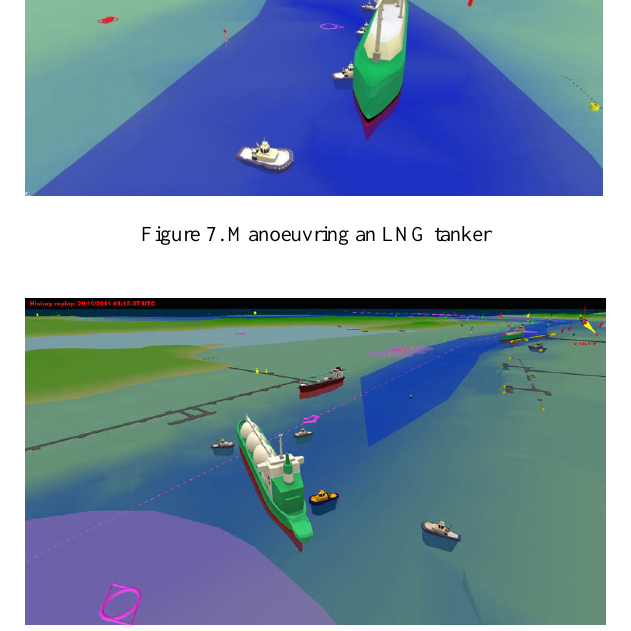
Figure 8. Turning an LNG tanker